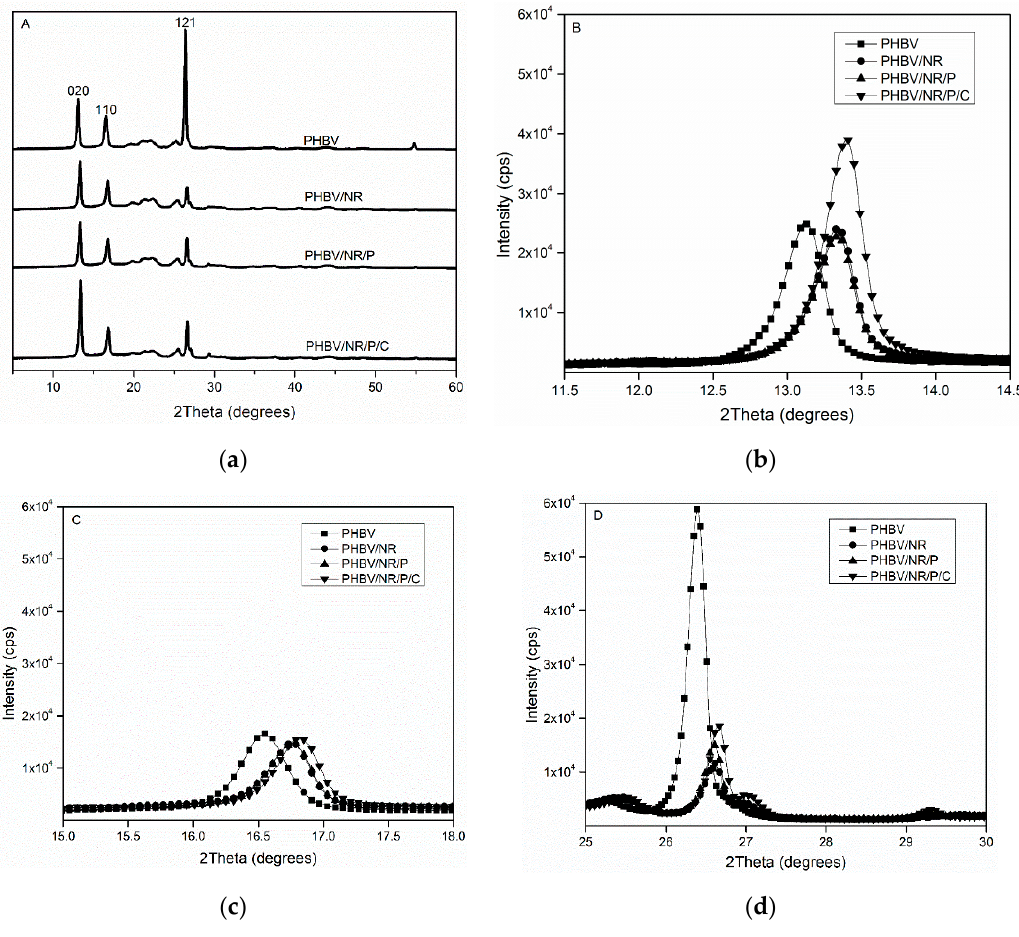
Figure 7. XRD patterns of pristine PHBV and the blends. ( a ) Overall XRD pattern from 2 θ = 5 ◦ to 2 θ = 60 ◦ ; ( b ) XRD pattern of diffraction peak (020); ( c ) XRD pattern of diffraction peak (110); ( d ) XRD pattern of diffraction peak (121).